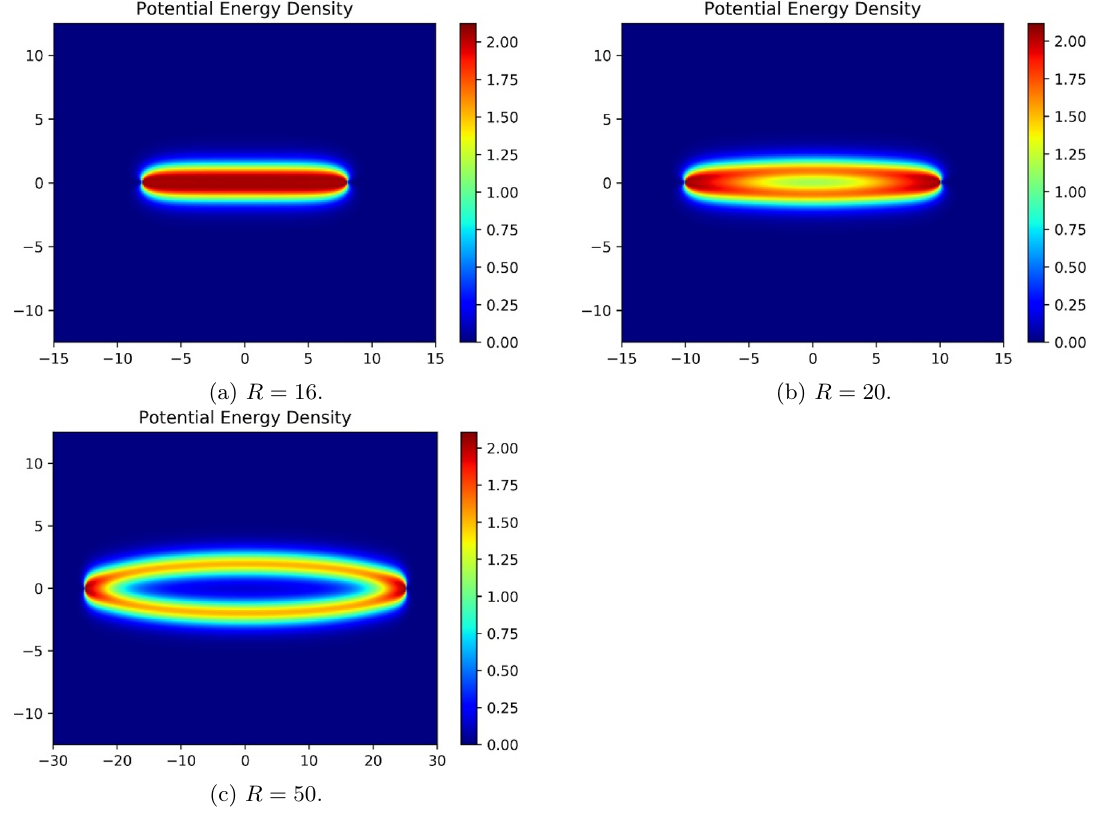
Figure 10. Gradual repulsion of two strings and the formation of a double-string configuration as the quark separation R increases, for N = 4 and quarks of weight w 1 . This phenomenon is also seen in high N -ality cases for N > 8 .